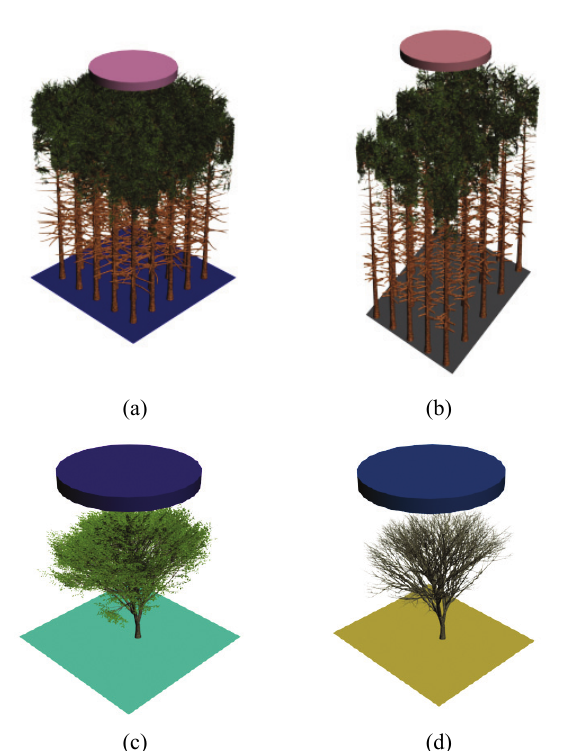
Figure 1. Overview of several samples of initial conditions of the simulated scenarios. (a), (b), (c) and (d) stands for corresponding to scenario number 1, 3, 13 and 14, respectively.